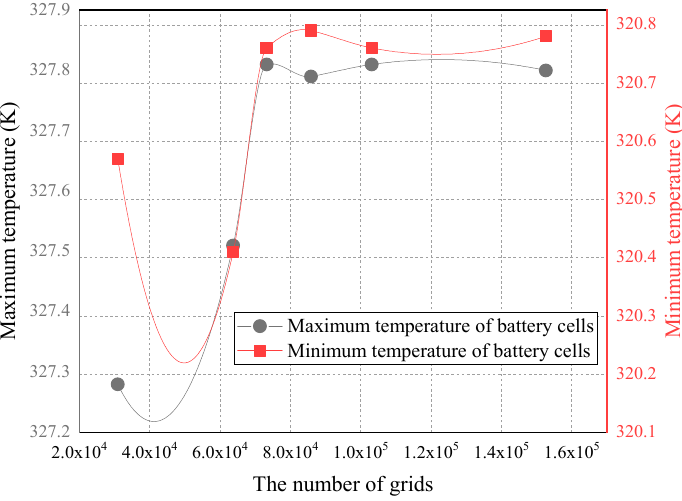
Figure 4. Simulation results of the basic model under different grid numbers.